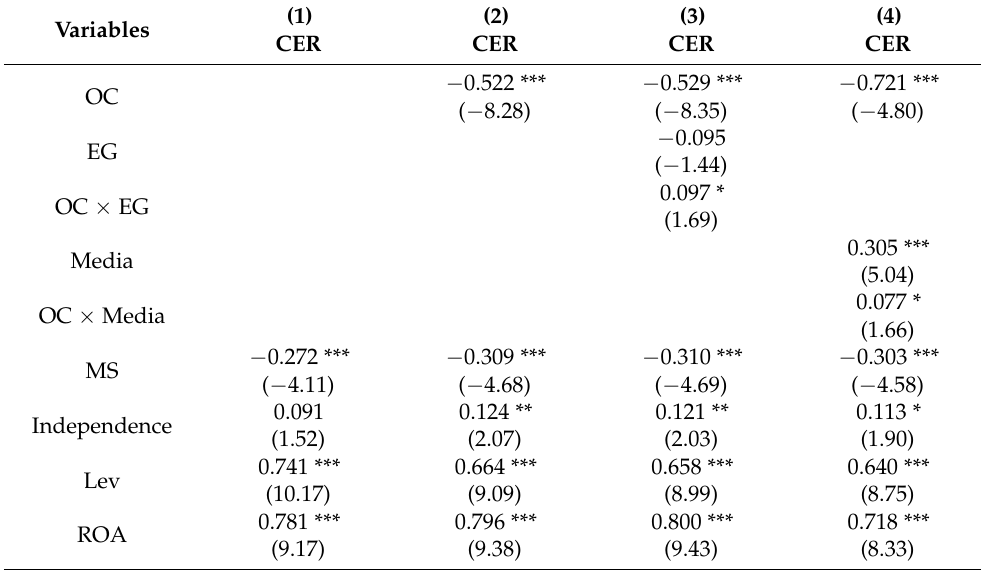
Table A2. Robustness (2)—Replace the independent variable measurement